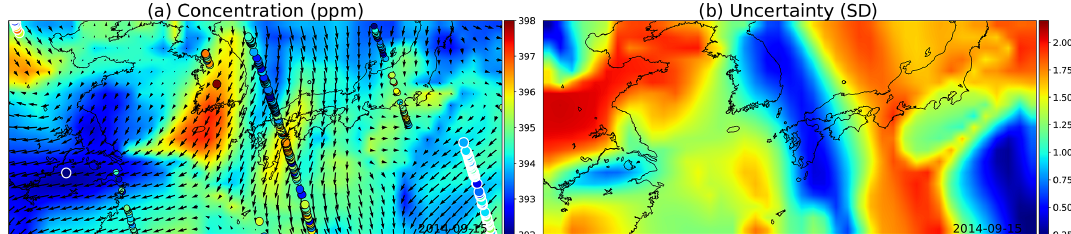
Figure 12. (a) GP posterior mean of XCO 2 and (b) its uncertainties with the wind-informed kernel. The area shown contains the Korean Peninsula in the center, China on the left, and Japan on the center right. The large circles with the white edges are present-day observations, medium circles are observations from adjacent days, and the smallest ones are observations from 2d away. Wind direction and magnitude are given by the black arrows, and uncertainty is clearly reduced where wind is blowing directly towards or away from the